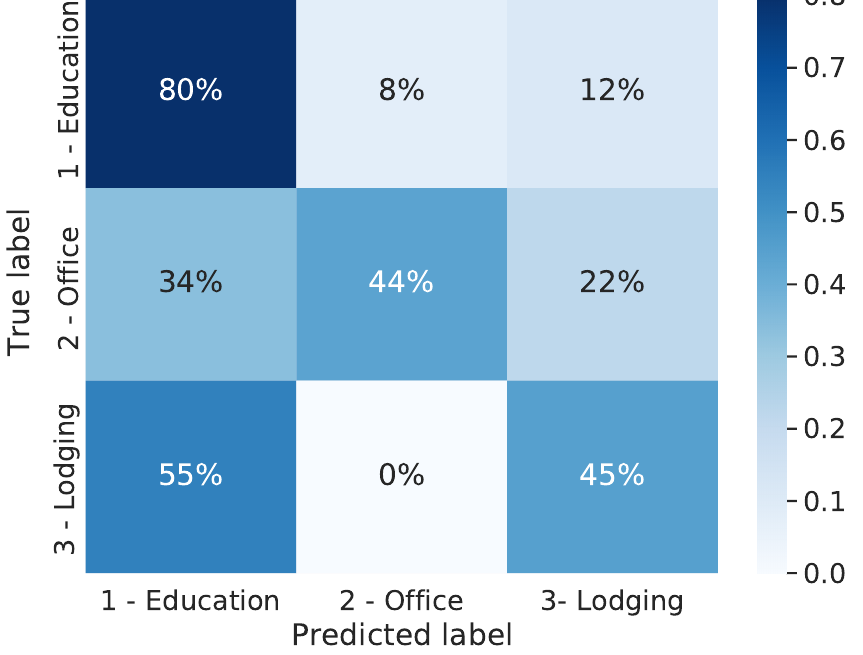
Figure 6. ANN-G+E normalized confusion matrix.